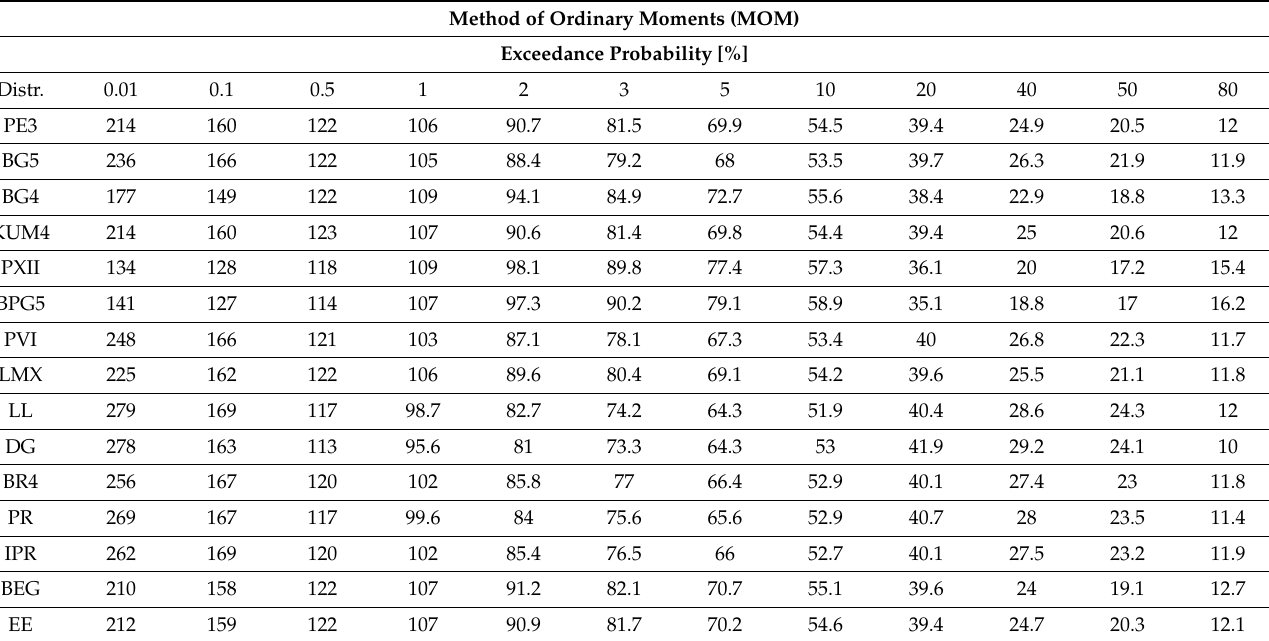
Table 5. Quantile results of the analyzed distributions for MOM.